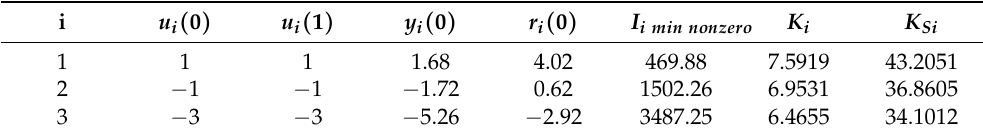
Table 2. Nonzero initial conditions and optimal